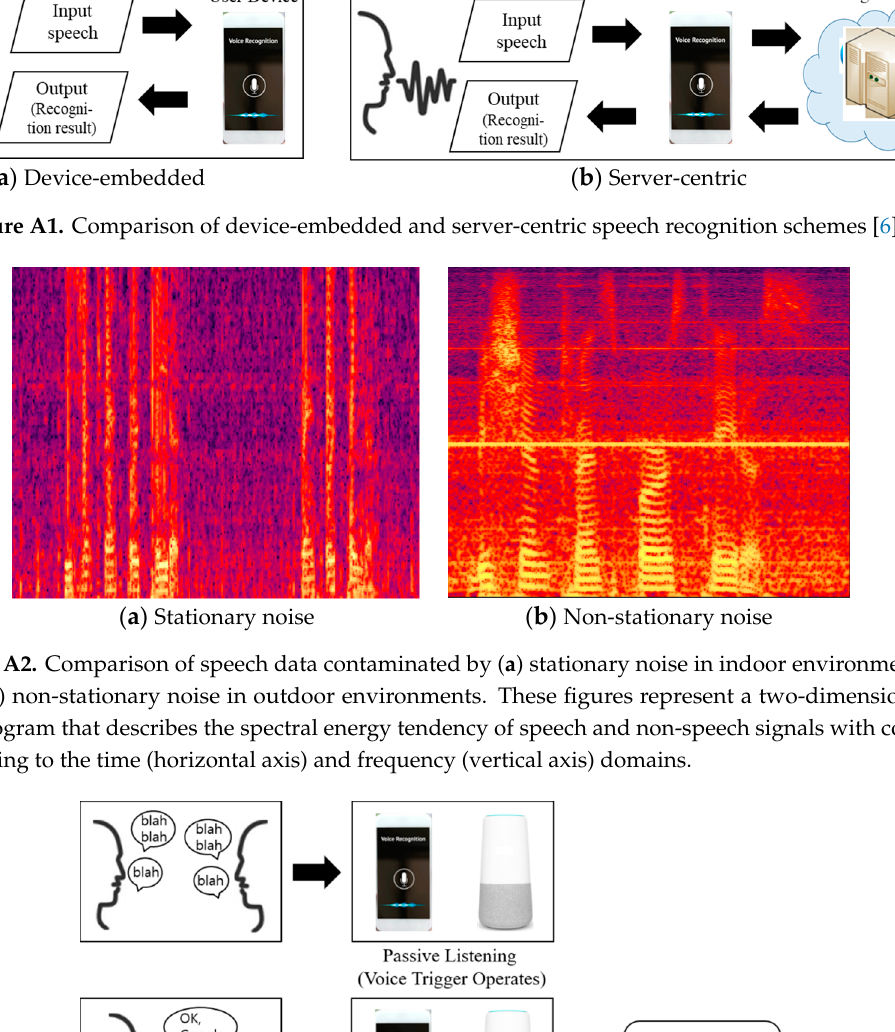
Figure A4. Communication flow of voice trigger-based multi-UAV control.